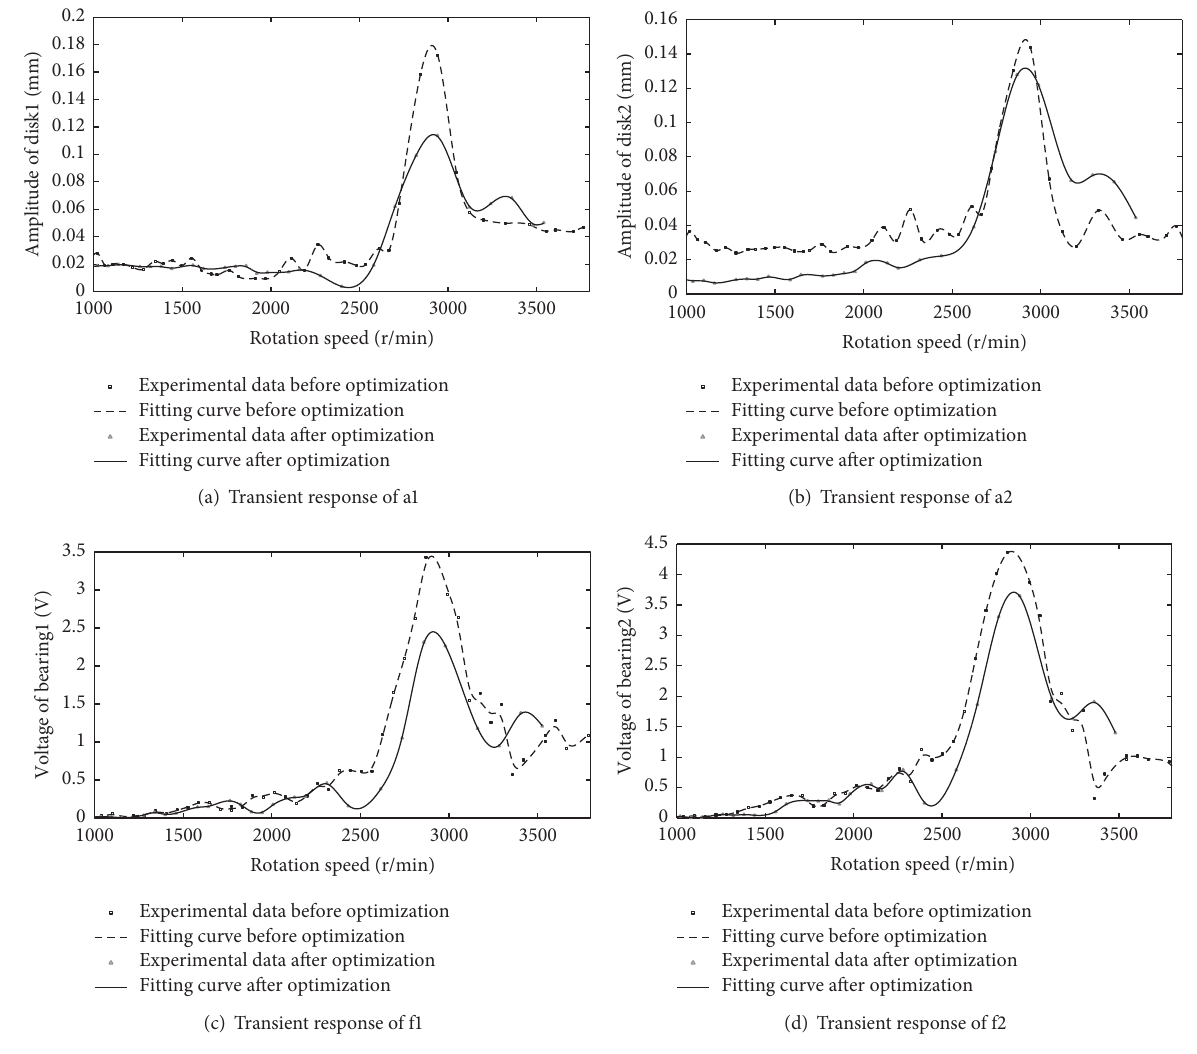
Figure 9: Transient response before and after optimization of Disk1 P and Disk2